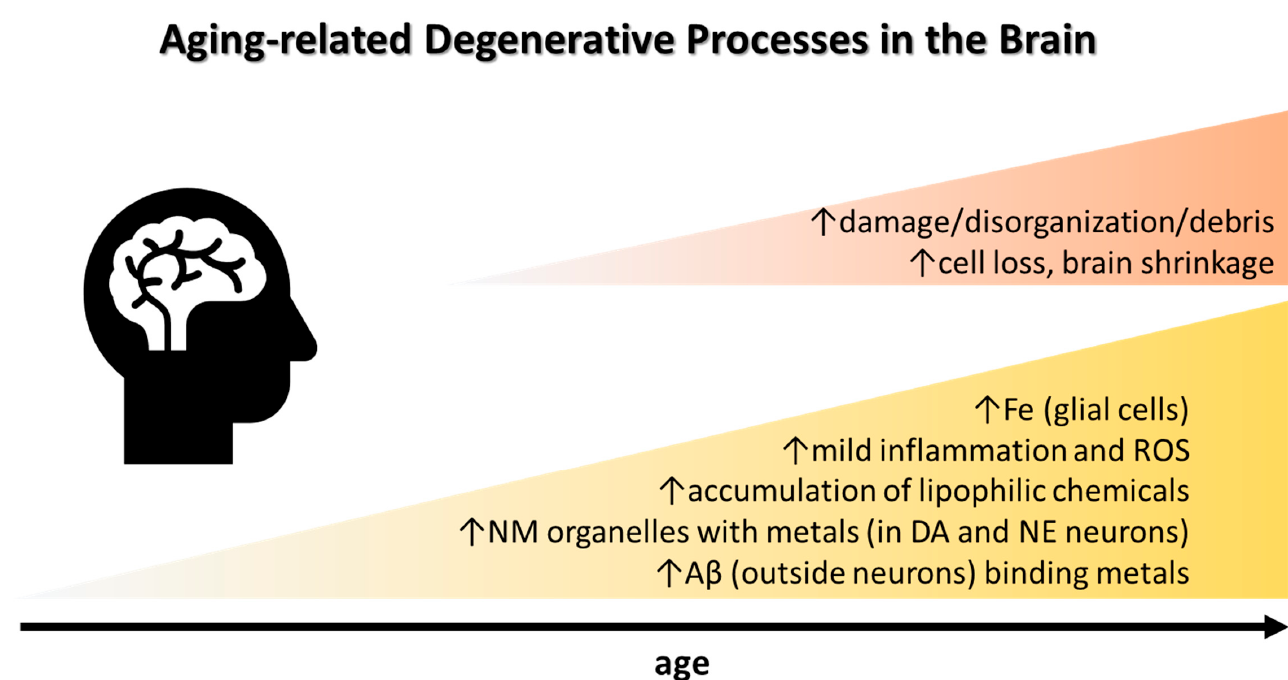
Figure 1. Common observations in healthy aging that may be accentuated in sporadic AD and PD. See text for details. Abbreviations: A β , amyloid-beta plaque; DA, dopamine; NE, norepinephrine;